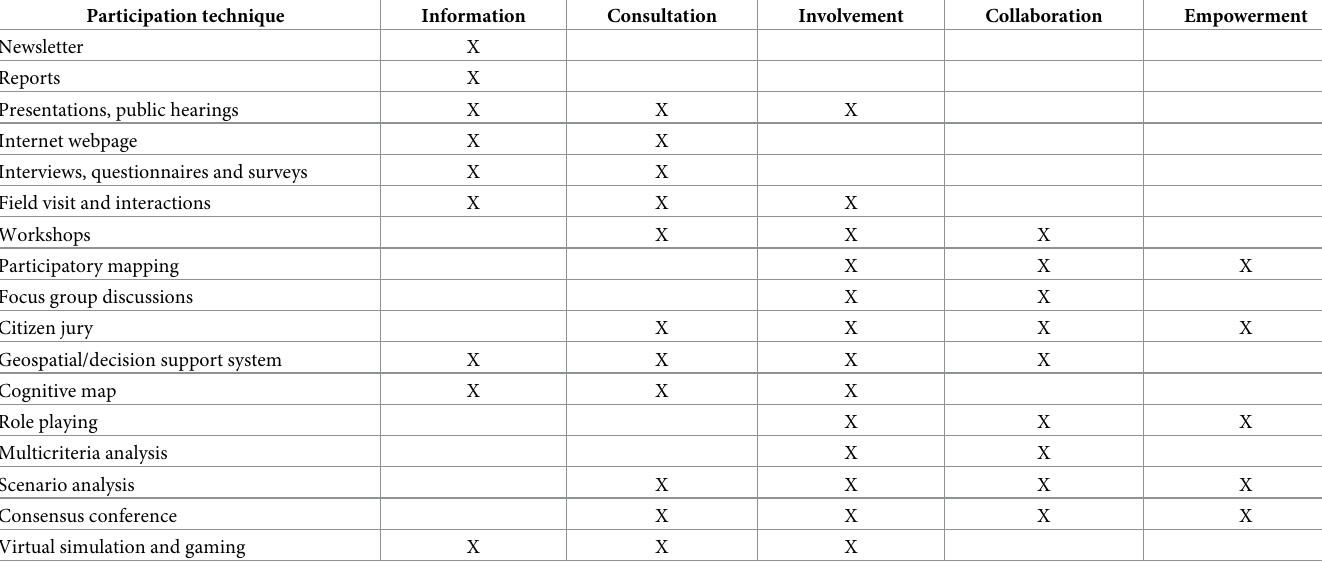
Table 1. Selected techniques of stakeholder participation in the context of involvement level. Participation